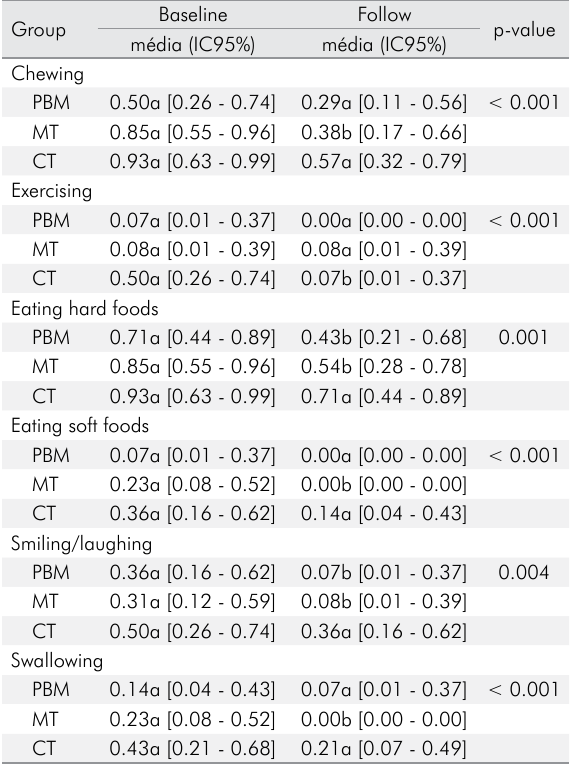
Table 9. Mean Beck anxiety inventory (BAI) scores in all groups at baseline and follow up.